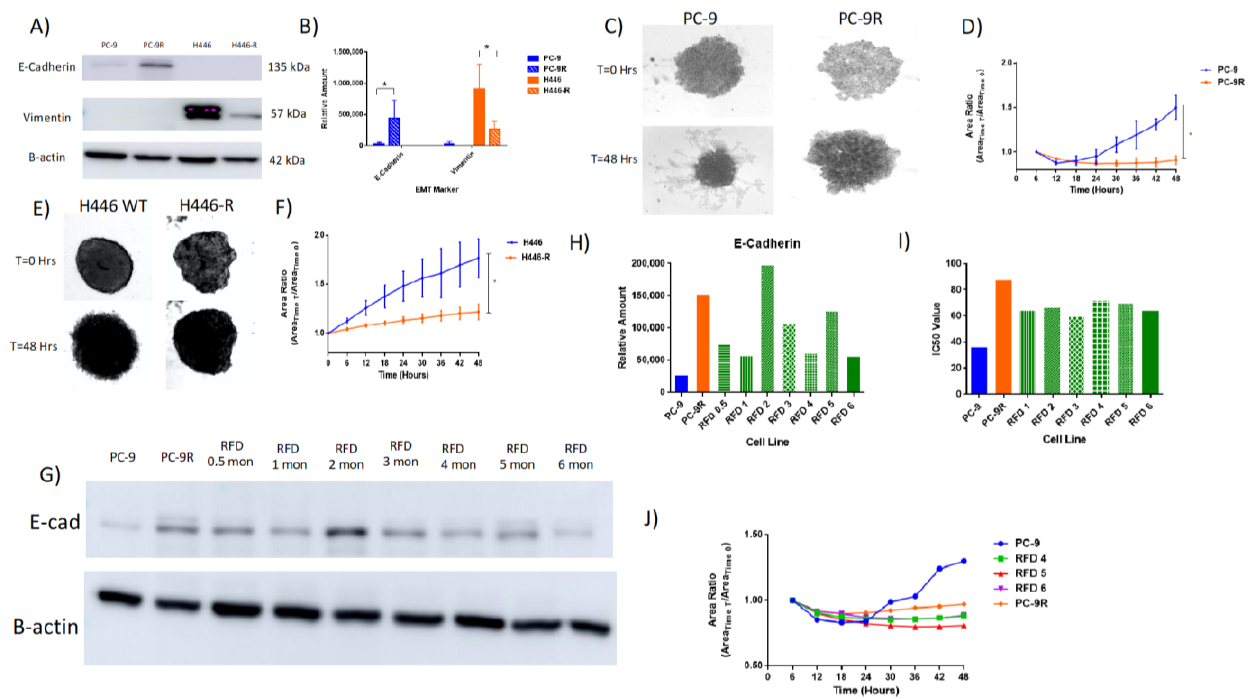
Figure 4. Emergence of Resistance to MTI-101 Selects for a Stable Phenotype Associated with Diminished Invasive Capacity and Increased Expression of Epithelial Markers. ( A ) PC-9 and H446 WT were compared to their respective MTI-101-resistant lines with respect to EMT protein markers. E-cadherin is an epithelial marker and was found to be overexpressed in the PC-9R cell line compared to WT. Vimentin is a mesenchymal marker and was found to be substantially decreased in H446- resistant cells compared to WT. Both corroborate a transition to a more epithelial-like cell phenotype (MET). ( B ) Quantification of Western blot. ( C ) PC-9 invasion assay comparing the WT to resistant cells’ ability to invade into the Matrigel over a 48 h time period. ( D ) Quantification of PC-9 invasion. ( E ) H446 invasion assay comparing the WT to resistant cells’ ability to invade into the Matrigel over a 48 h time period. ( F ) Quantification of H446 invasion. ( G ) Western blot comparing E-cadherin expression when PC-9R is removed from drug pressure over a 6-month period. ( H ) Quantification of Western blot for E-cadherin in PC-9 removed from drug (RFD). ( I ) IC 50 values of MTTs run with MTI-101 treatment comparing PC-9 to its respective resistant and RFD cells. ( J ) Invasion assay showing lack of invasion of PC-9 RFD even after six months compared to PC-9 wild type cell line. Completed as n = 3 independent experiments, reproducible representative images shown for invasion images and Western blots. Error bars represent SEM (significances denoted * for p < 0.05, two-tailed T- test).